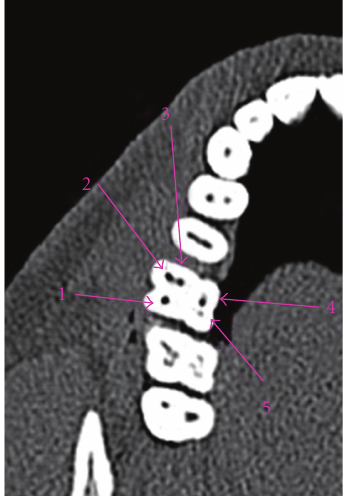
Figure 4: Maxillary molar with 5